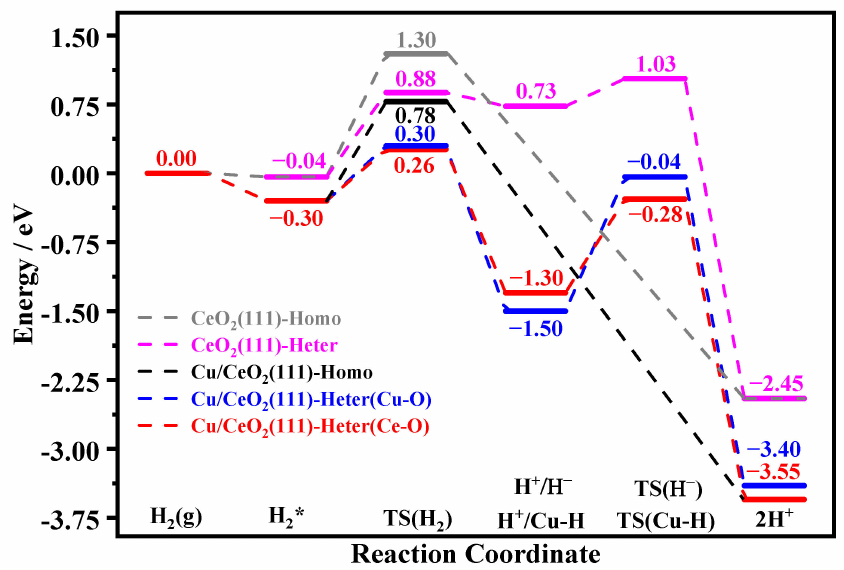
Figure 3. Calculated energy profiles of homolytic (Homo) and heterolytic (Heter) H 2 dissociation on the CeO 2 (111) and Cu/CeO 2 (111) surfaces. “*” is defined as the surface free site, and this notation is used throughout the